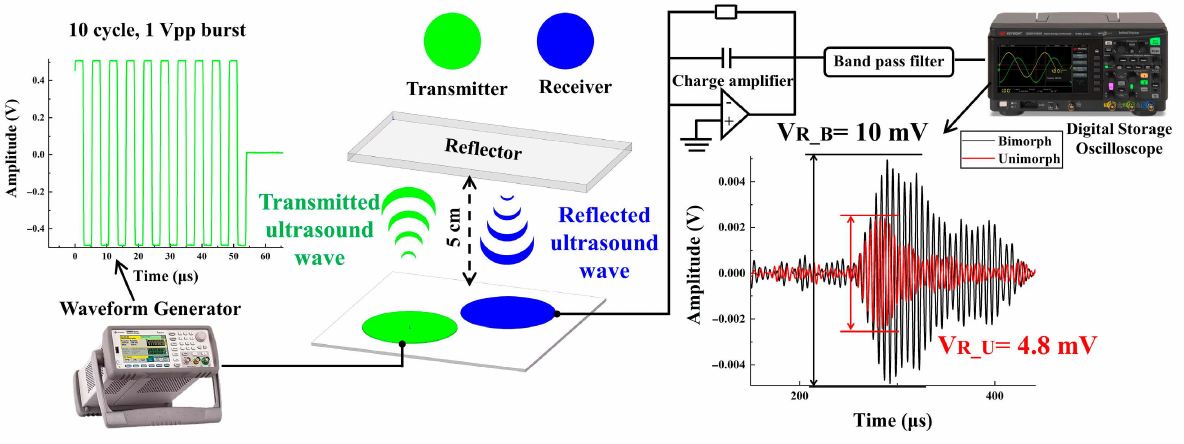
Figure 13. Setup and results for pulse-echo experiment.